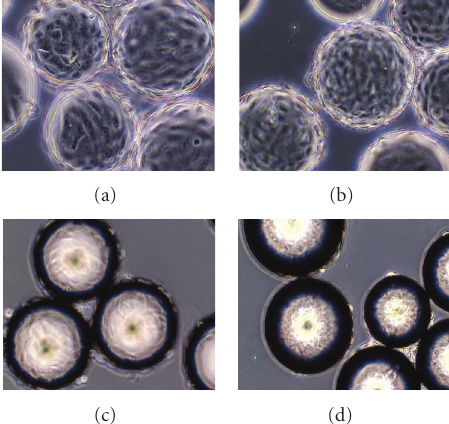
Figure 1: Comparison of Vero cell growth in four di ff erent culture media. All media were supplemented with 10% fetal bovine serum (FBS).